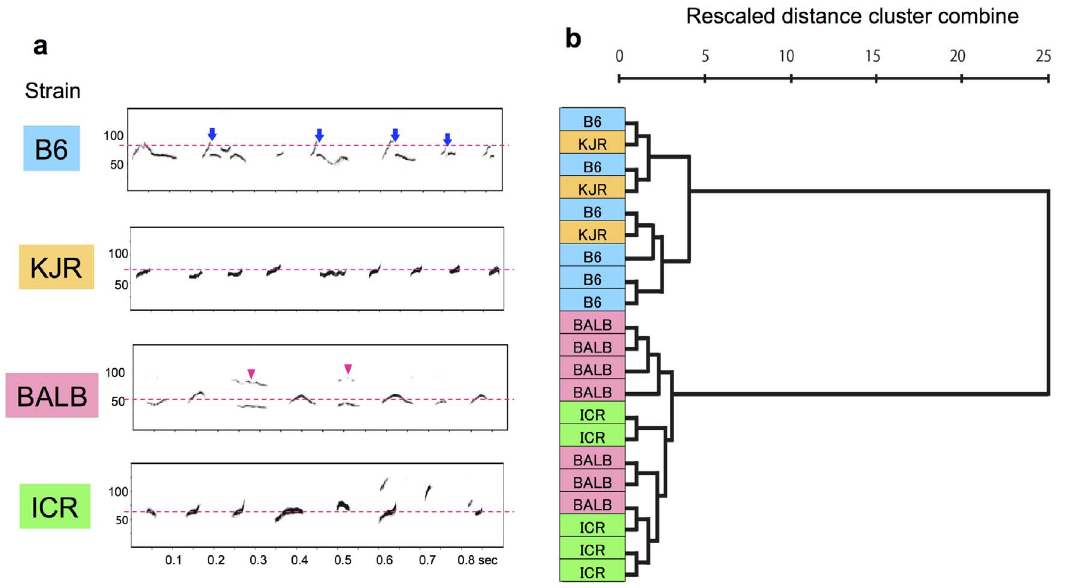
Figure 1. Strain-specific characteristics of male mouse songs. ( a ) Representative spectrogram of the songs from B6, KJR, BALB, and ICR. Arrows and arrowheads indicate the ‘‘Jump’’ (B6) and ‘‘Harmonic’’ waveforms (BALB), respectively. The dotted lines indicate the average peak frequency of each song (B6, 79 kHz; KJR, 75 kHz; BALB, 55 kHz; ICR, 66 kHz). ( b ) Cluster analysis using the following parameters: mean peak frequency of syllables, interval between syllables, duration of syllables, and percentage composition, for each waveform category among B6, BALB, ICR, and KJR male individuals (B6, n =6; BALB, n =7; ICR, n =5; KJR, n =3). There were 2 major song groups: BALB and ICR, and B6 and KJR.